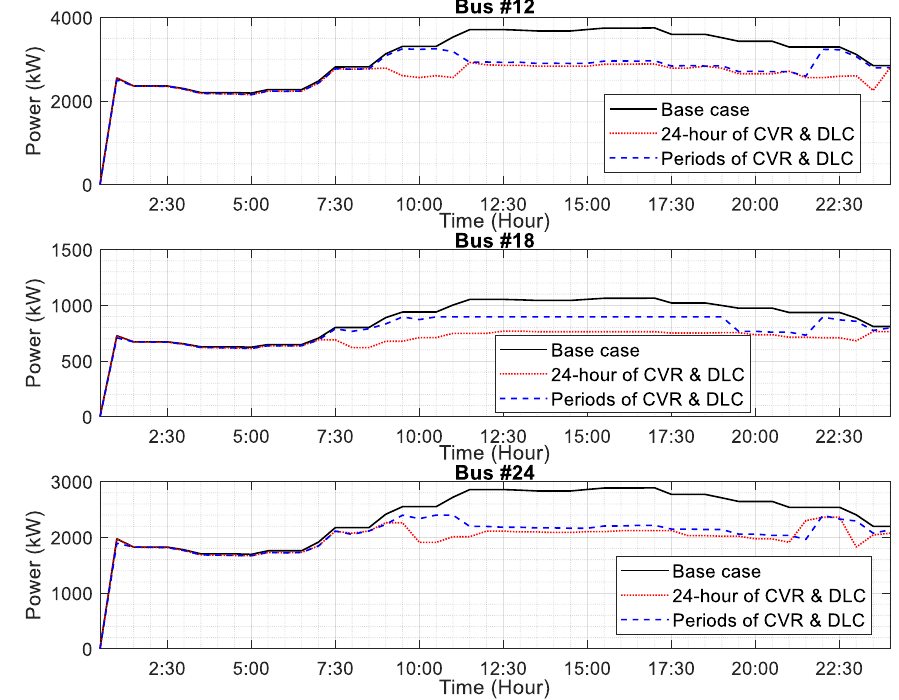
Figure 16. Case VII: Power vs. time with/without CVR and DLC.